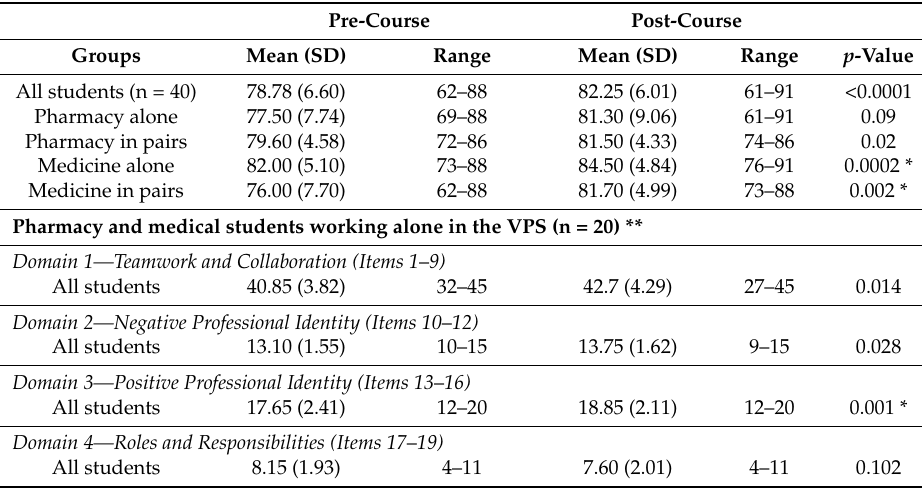
Table 1. Readiness for Interprofessional Learning Scale (RIPLS)